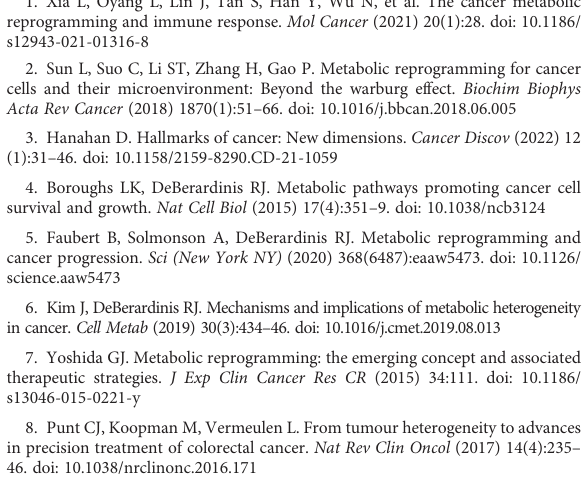
SUPPLEMENTARY FIGURE 6 Identi fi cation of differentially expressed hub metabolites signi fi cantly associated with GC stage, grade and type. Correlation between 34 HER2- coexpressed metabolites and tumour (A) stage, (B) grade and (C) type. (D) The expression distribution of the HER2-coexpressed metabolites associated with tumour stage, grade and type in tumour and healthy samples. Only metabolites with a p-value of <0.05 are demonstrated. SUPPLEMENTARY FIGURE 7 Panoramic view of the (A) SNV, (B) CNV ampli fi cation and (C) CNV deletion frequencies of the top 20 mutated genes across the four metabolic subtypes. SUPPLEMENTARY FIGURE 8 Panoramic view of the speci fi c molecules (A : mRNA, B : miRNA, C : lncRNA ) of each metabolic subtype. SUPPLEMENTARY FIGURE 9 Panoramicviewofglycolysis/gluconeogenesis metabolism-related genes in pan-cancer. (A) Changes in the mRNA expression of glycolysis/ gluconeogenesis metabolism-related genes across cancer types. The frequencies of copy number variation (B) and single-nucleotide variation (C) in diverse types of cancers. (D) Enrichment analysis for cancer pathway signalling between tumour samples with high and low enrichmentscoresofthegenes. (E) Survivallandscapeofthegenesacross cancer types. (F) Heatmap demonstrating the methylation levels of the genes across cancer types. SUPPLEMENTARY FIGURE 10 Panoramic view of alanine – aspartate – glutamate metabolism-related genes in pan-cancer. (A) Changes in the mRNA expression of alanine – aspartate – glutamate metabolism-related genes across cancer types. The frequencies of copy number variation (B) and single-nucleotide variation (C) indiversetypesofcancers. (D) Enrichmentanalysisforcancerpathway signalling between tumour samples with high and low scores of the genes. (E) Survival landscape of the genes across cancer types. (F) Heatmap demonstrating the methylation levels of the genes across cancer types. SUPPLEMENTARY FIGURE 11 Relationship between ERBB2 expression and glycolysis/gluconeogenesis (A) and alanine – aspartate – glutamate (B)